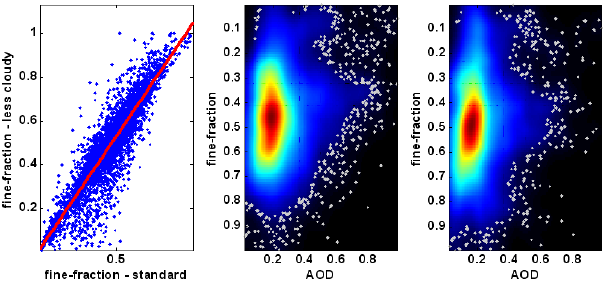
Fig. 3. Left: Correlations between aerosol fine fraction ratio: the standard product (x-axis) and after applying a stringent 20% cloud fraction threshold to retain the least cloudy scenes (y-axis). Data are aggregated at 1 ◦ . Middle: 2-D normalized histogram (black = zero, red = 1) of the AOD and fine fraction for the data before fil- tering AOD pixels with high cloud content. Right: 2-D normalized histogram (black = zero, red = 1) of the AOD and fine fraction for the data after filtering AOD pixels with high cloud content.